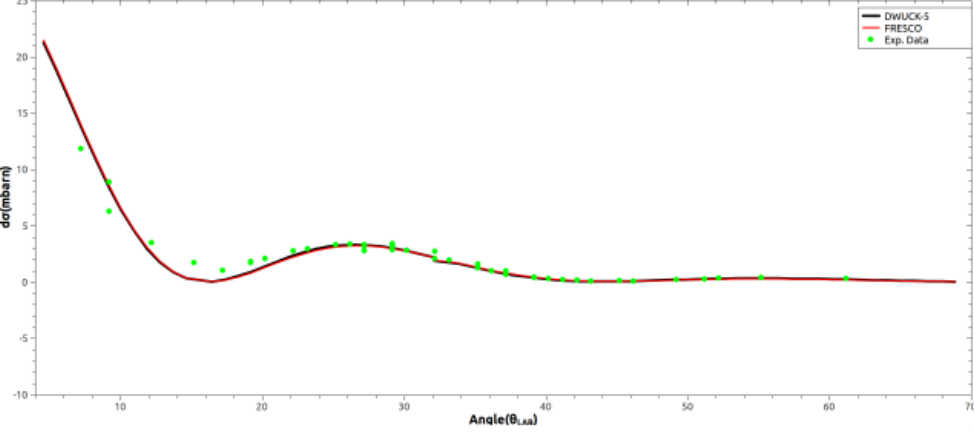
Figure 2. Angular distributions for ground state (same procedure for the first excited state has also been made) for the reaction 26 Mg(d,p) 27 Mg. The curve is extracted by means of DWBA calculations. More details will be given in a forthcoming